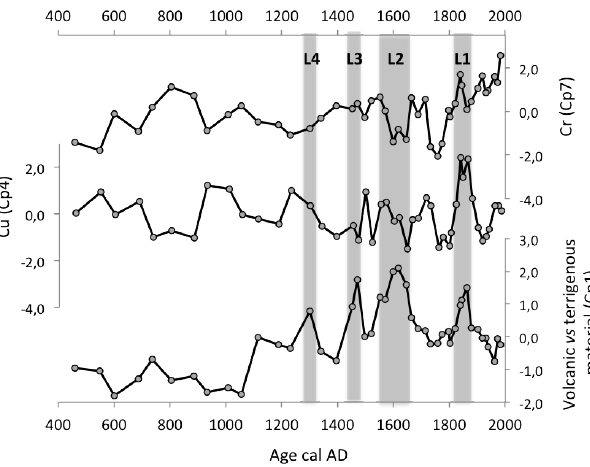
Figure 6. Chronology of the main changes in the chemical com- position of the sediments of Limnopolar Lake during the last 1600 years. L1 to L4: layers enriched in Ca, Ti, Zr, and Sr, which are interpreted as